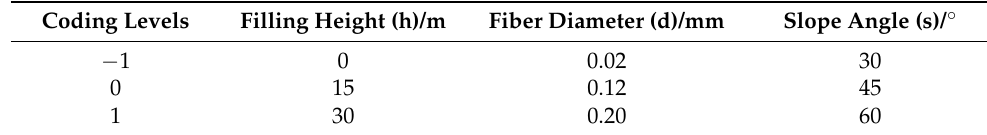
Table 3. Code of influencing